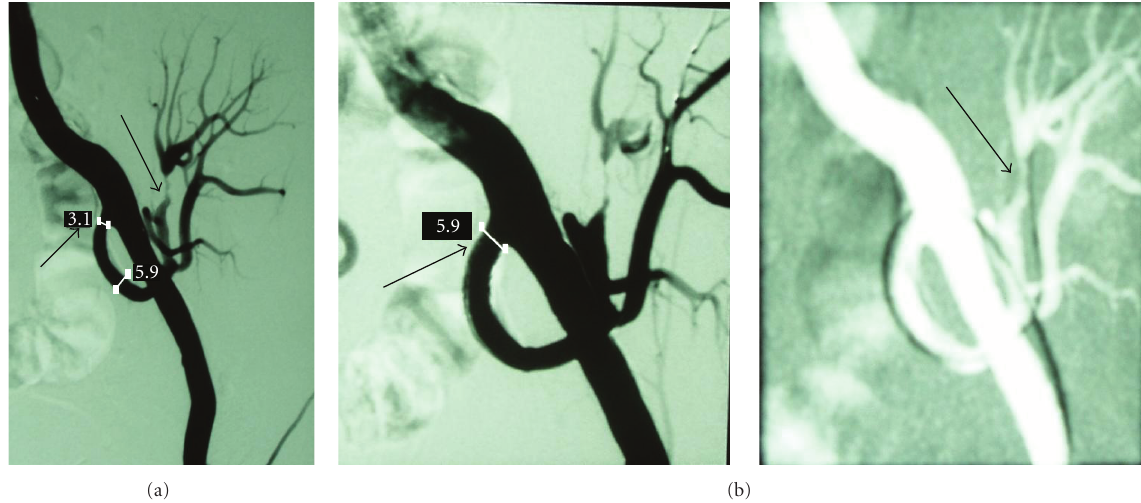
Figure 2: (a) Angiography of the iliac artery revealing the anastomotic stenosis of the transplant renal artery (small arrow) as well as stenosis of the upper segmental renal artery (big arrow). (b) Left. Postangioplasty with stent placement at the proximal transplant renal artery (arrow). Right. After slight dilatation of segmental renal artery with a thin coronary balloon